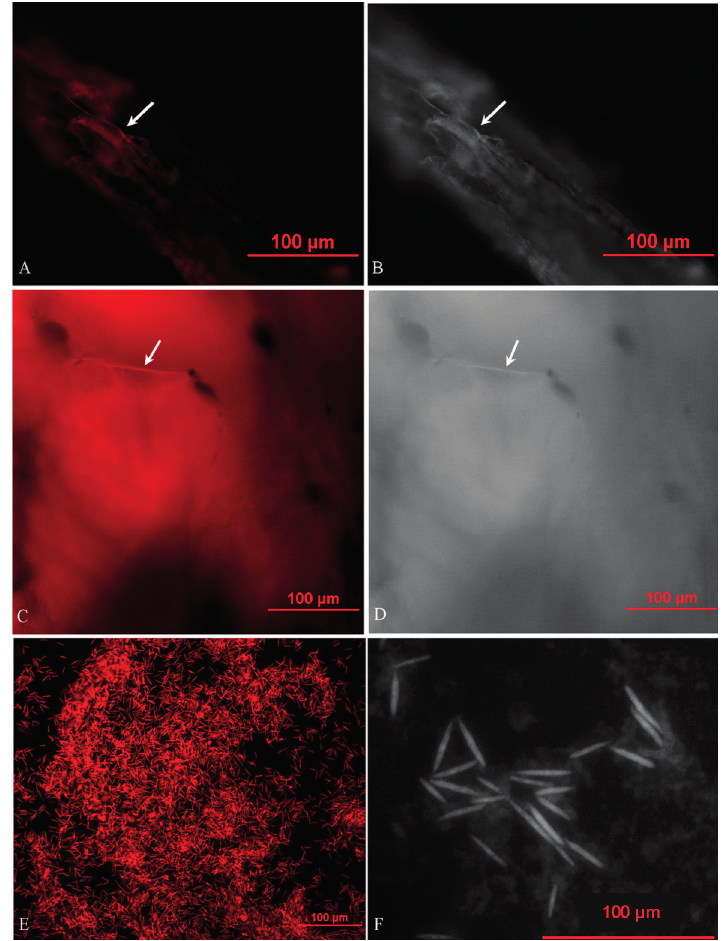
Figure 3. Fluorescence in situ hybridization (FISH) with the specific O. sinensis probe (OSP) of O. sinensis . ( A ) Cy5-OSP-labeled micrograph of the O. sinensis hyphae in the plant root; ( B ) light micrograph of the O. sinensis hyphae in the plant root; ( C ) Cy5-OSP-labeled micrograph of the O. sinensis hyphae in the caterpillar intestinal-wall; ( D ) light micrograph of the O. sinensis hyphae in the caterpillar intestinal-wall; ( E ) Cy5-OSP-labeled micrograph of the O. sinensis endosymbionts in the caterpillar haemolymph; ( F ) light micrograph of the O. sinensis endosymbionts in the caterpillar haemolymph. The red hybridization signal is indicated with an